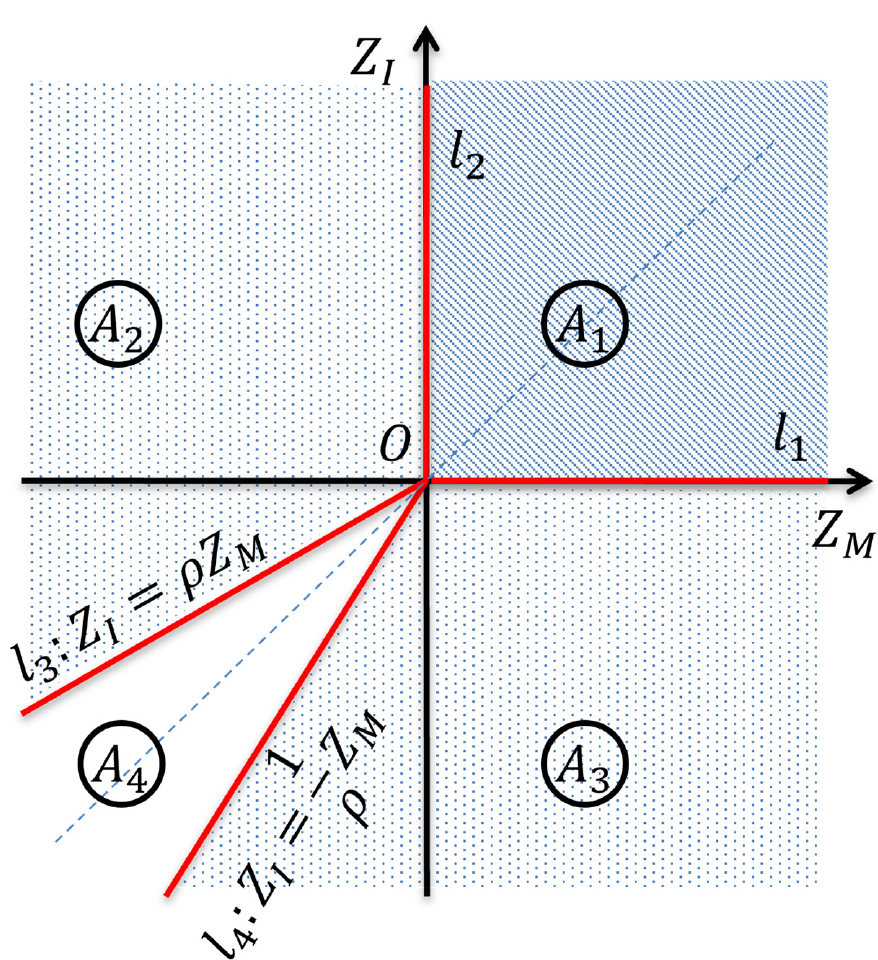
where q i = P (( Z M , Z I ) ∈ A i ) .